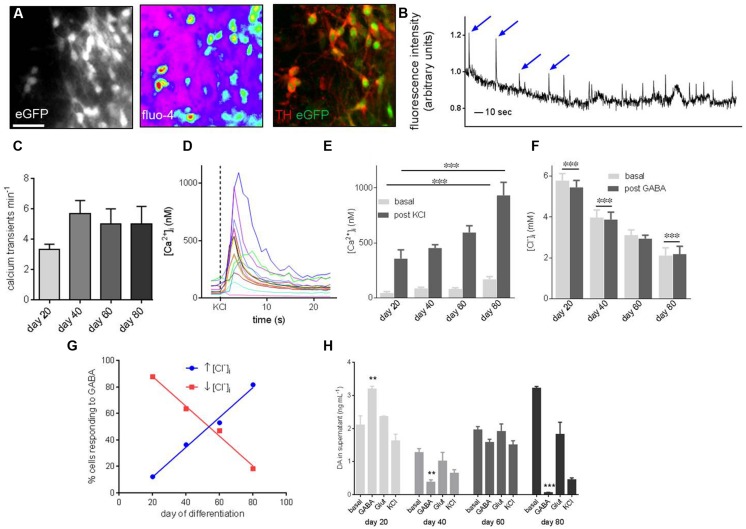
Functional characterization of PITX3eGFP/w neurons reveals development of maturity during terminal differentiation.
(A) Ca2+ and Cl- imaging was employed to probe the function of PITX3eGFP/w neurons. These panels show, from left to right, eGFP in a field of view prior to imaging, the Ca2+ -sensitive probe Fluo-4 loaded into cells of the same field, and TH and eGFP after post-imaging immunocytochemistry. (B) Shows a representative trace from a Ca2+ imaging experiment. Spontaneous oscillations of [Ca2+]i, typical of in vitro mDA neurons are highlighted by arrows. The y-axis represents change in fluorescence: baseline fluorescence (ΔF/F). (C) The frequency of these oscillations did not change significantly by day 80 (one-way ANOVA with post hoc Dunnett’s test, indicates p > 0.05, n = 3 wells, 60–80 cells). (D) Intracellular calcium ion concentration ([Ca2+]i) in PITX3eGFP/w neurons was calculated at rest and after stimulation with KCl (30 mM). (E) Basal and KCl-induced elevations of [Ca2+]i increased during differentiation (one-way ANOVA with post hoc Dunnett’s test, ∗∗∗ indicates p < 0.001, n = 3 experiments, 40–80 cells). (F) Similarly, GABA (30 mM) decreased [Cl-]i at day 20 and 40 of differentiation, by day 80 GABA induced a significant increase in [Cl]i (Student’s paired t-test, ∗∗∗ indicates p < 0.001, n = 4, 60–80 cells). (G) By day 80 most PITX3eGFP/w neurons respond to GABA with an elevation of [Cl-]i (blue; R2 = 0.99), rather than the decrease seen at earlier days of differentiation (red; R2 = 0.99). (H) Shows the change in dopamine concentration in the supernatant of eGFP+ cultures following vehicle addition (i.e., basal level), GABA (30 mM), l-glutamate (30 mM) or KCl (30 mM) at different days of culture. Dopamine release in response to GABA (30 μM), but not l-glutamate or KCl significantly decreased from days 20 to 80 of differentiation (one-way ANOVA with post hoc Dunnett’s test compared to day 20, ∗∗, ∗∗∗ indicates p < 0.01 and 0.001, respectively, n = 3 wells).